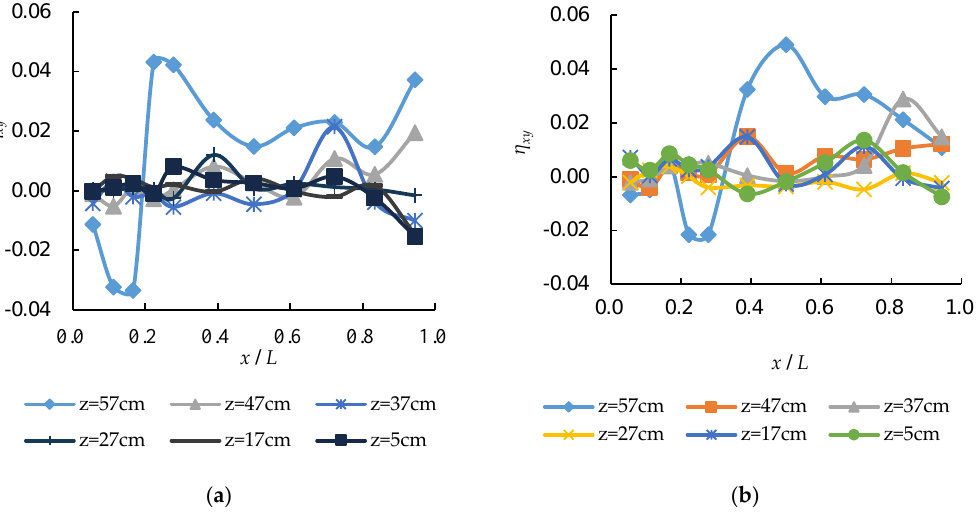
Figure 10. Variation in Reynolds stress along flow direction on the xoy plane. ( a ) Q 1 = 20.79 L / s; ( b ) Q 2 = 30.04 L / s.